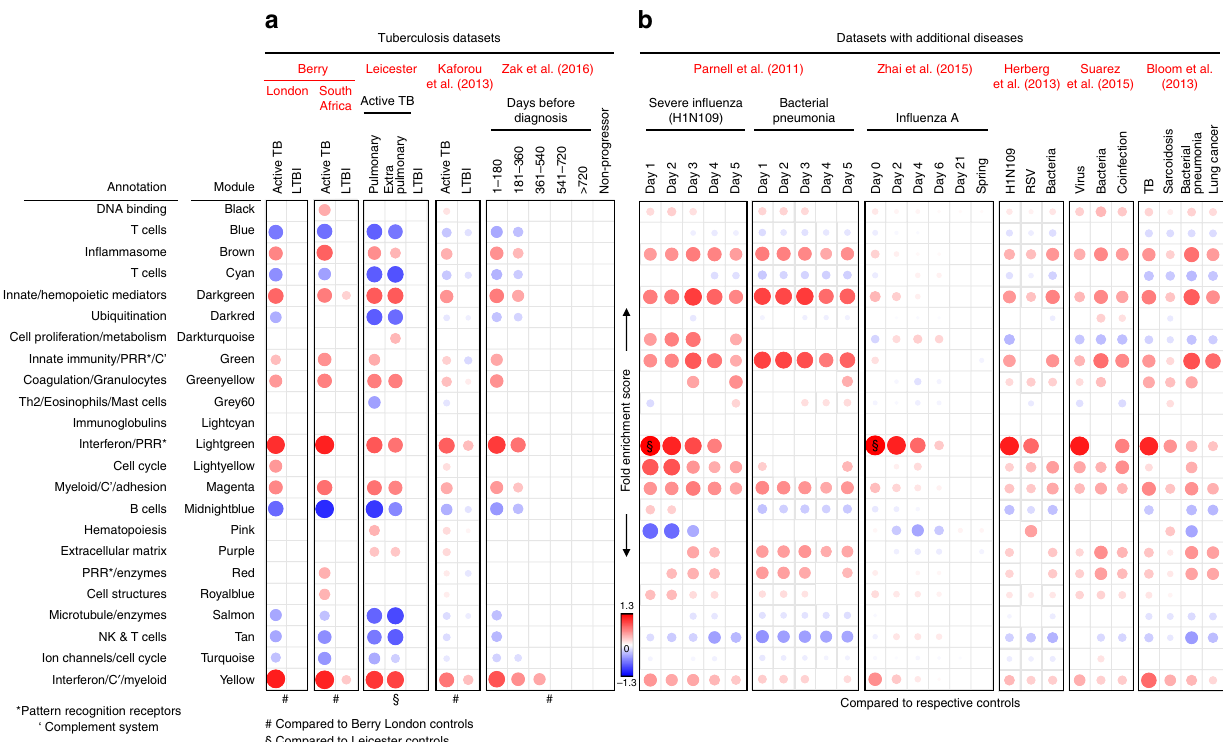
Fig. 4 Modular transcriptional signatures of TB and other diseases. a Twenty-three modules of co-expressed genes derived using WGCNA from Combined Berry dataset (London and South Africa) and tested in other TB datasets, and b datasets with additional diseases. Fold enrichment scores derived using QuSAGE are depicted, with red and blue indicating modules over- or underexpressed, compared to the controls. Colour intensity and size represent the degree of enrichment, compared to the controls. Only modules with fold enrichment scores with FDR p -value < 0.05 were considered signi fi cant and depicted here. §, fold enrichment scores in the lightgreen module greater than the maximum score depicted on the scale (i.e. >1.3) in severe in fl uenza (Parnell et al. 35 , score: 1.55) and in fl uenza A (Zhai et al. 36 , score: